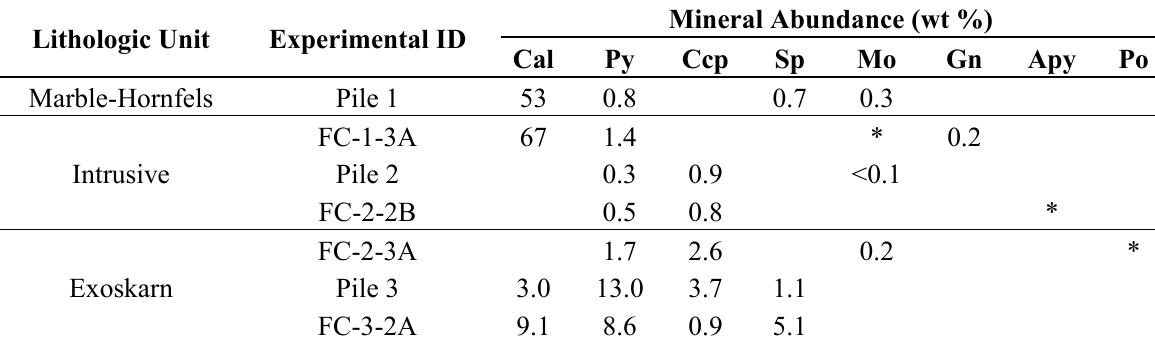
Table 2. Results of mineralogical investigation using X-ray diffraction (XRD) and scanning electron microscopy-energy dispersive X-ray spectroscopy (SEM-EDS). Minerals detected by XRD are reported in wt % determined during Rietveld